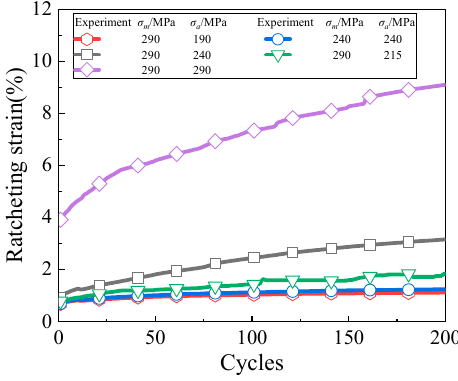
Figure 4. Experimental values of ratcheting.